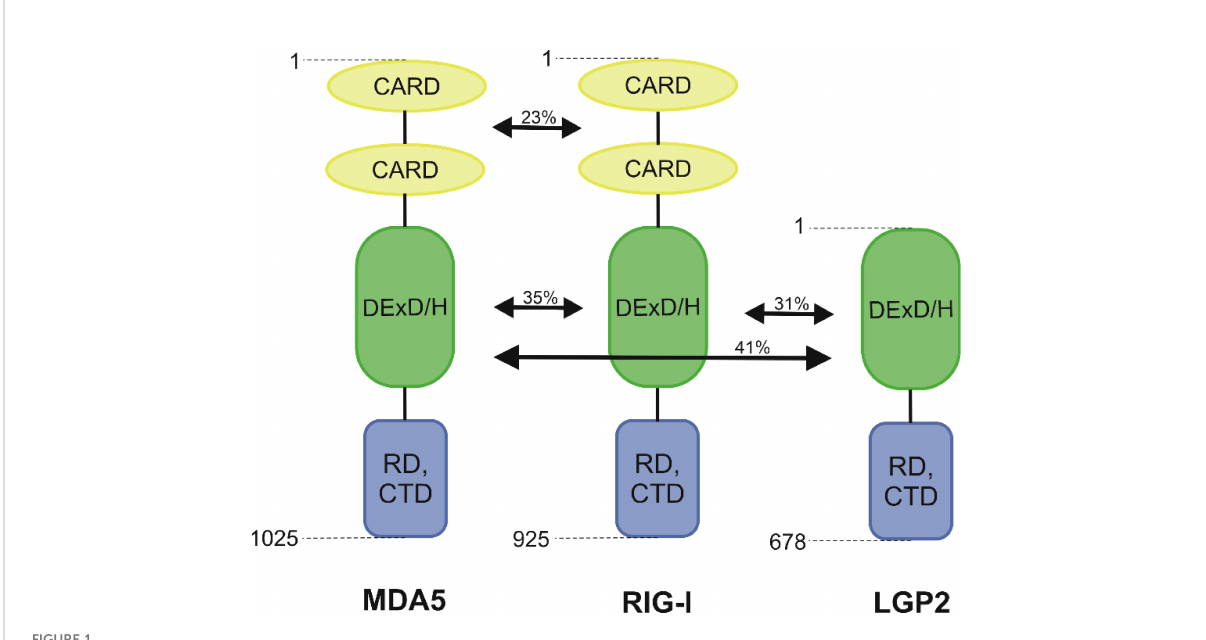
FIGURE 1 Schematic structure of RIG-I-like